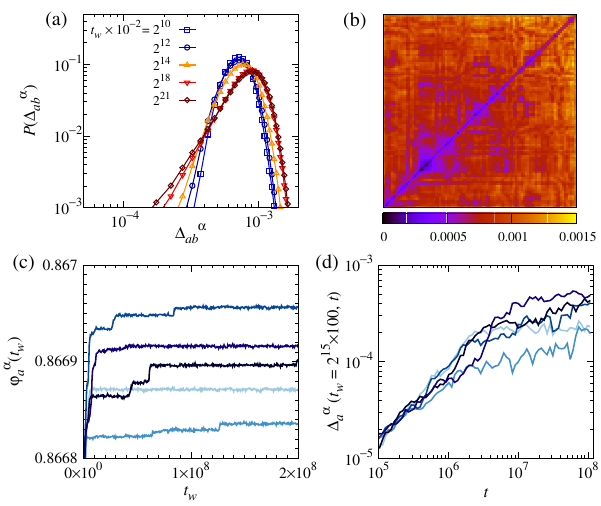
FIG. 10. Exploration of the landscape of sample α with N ¼ 1024 compressed at Z ¼ 10 000 . (a) Time evolution of Þ . (b) Corresponding heat map probability distribution P ð Δ α ab ¼ 2 21 × 100 . (c) Diversity of activated events in indivi- at t w dual clones are captured by small jumps in the packing frac- tion. (d) Corresponding evolution of the individual MSD at ¼ 2 15 × 100 t w